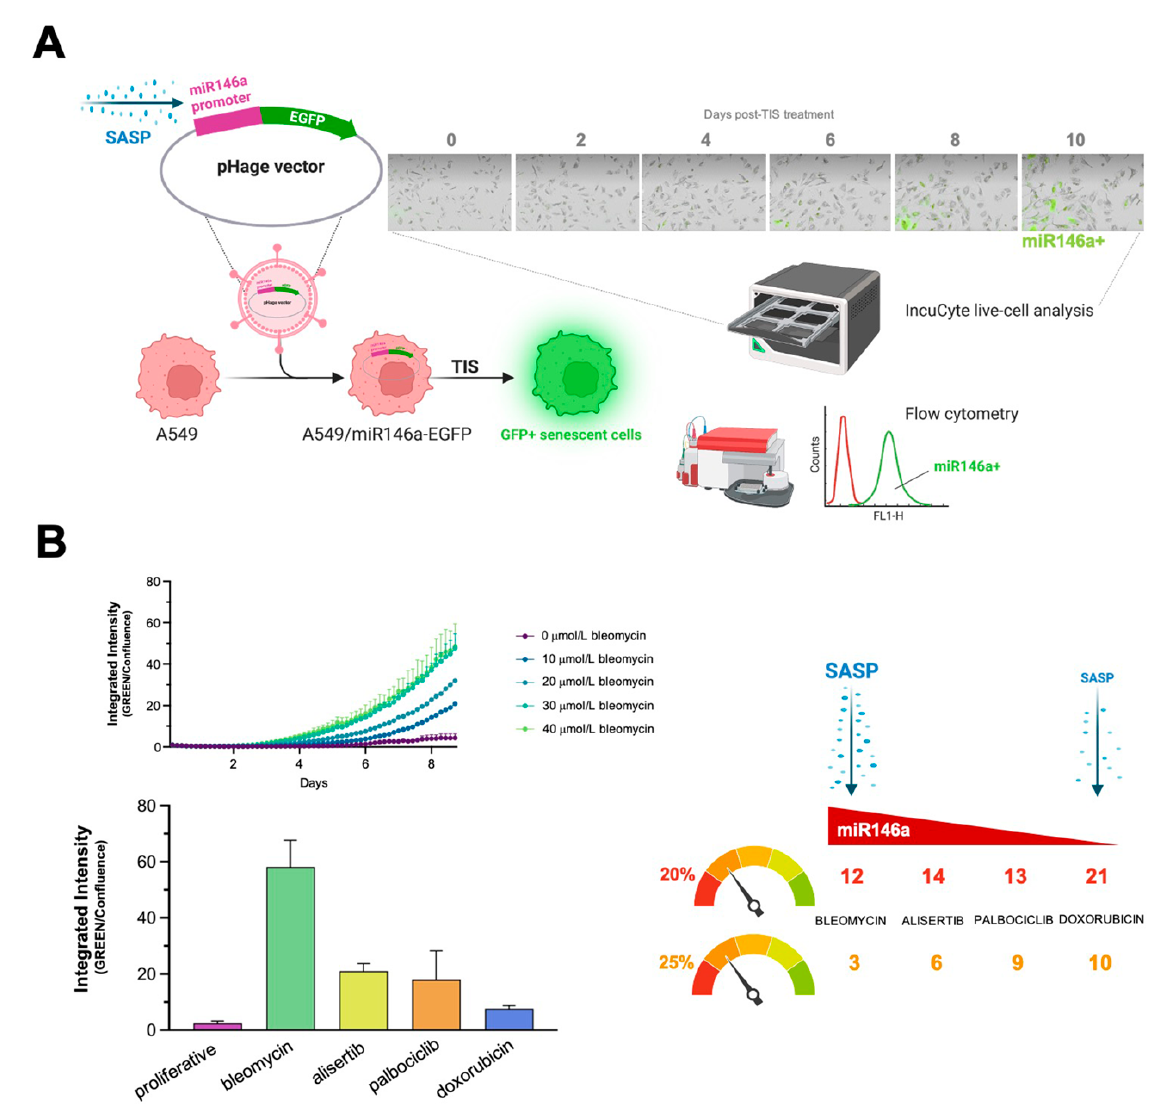
Figure 4. Activation levels of the negative-feedback regulator of the SASP response, miR-146a, and diversity of nutritional rescue of glucose deprivation in therapy-induced senescence cells. ( A ) The miR146a-EGFP reporter detects senescence in A549 cells. The SASP-responsive miR146a-